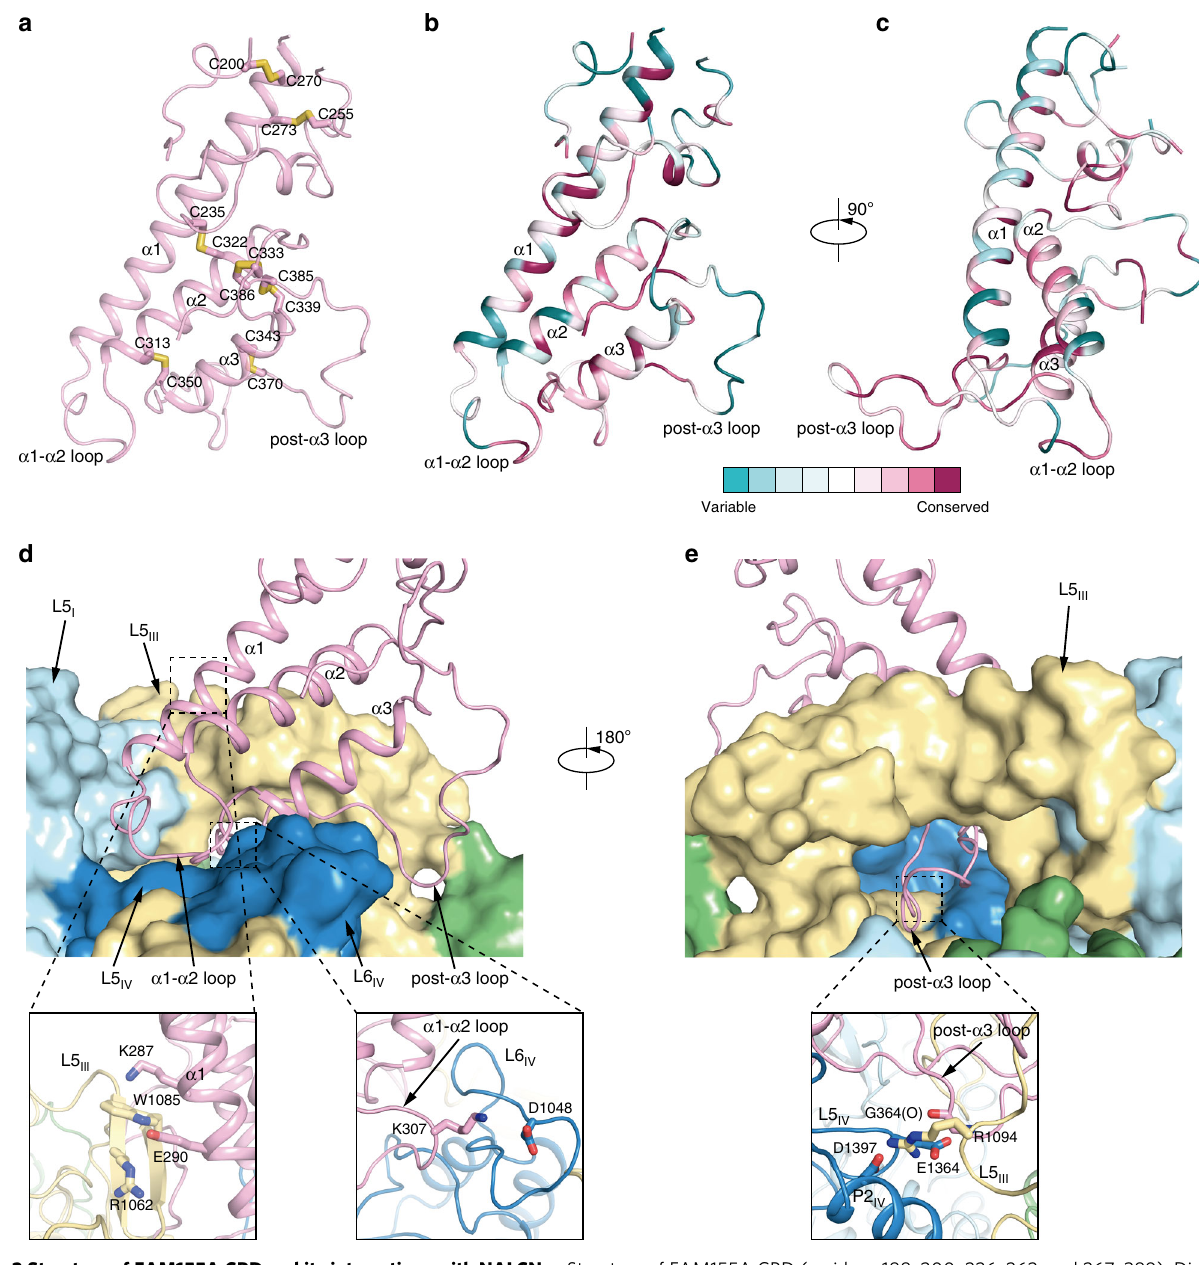
Fig. 2 Structure of FAM155A CRD and its interactions with NALCN. a Structure of FAM155A CRD (residues 188 – 200, 226 – 262, and 267 – 389). Disul fi de bonds are shown as yellow sticks. b Structural mapping of conserved residues of FAM155 family members, generated by ConSurf 50 . c A 90° rotated view compared to b . d Interactions between FAM155A and NALCN. FAM155A is shown as a cartoon. NALCN is shown as a surface. Key interaction regions are boxed and zoomed in the close-up views below. e A 180° rotated view compared to d